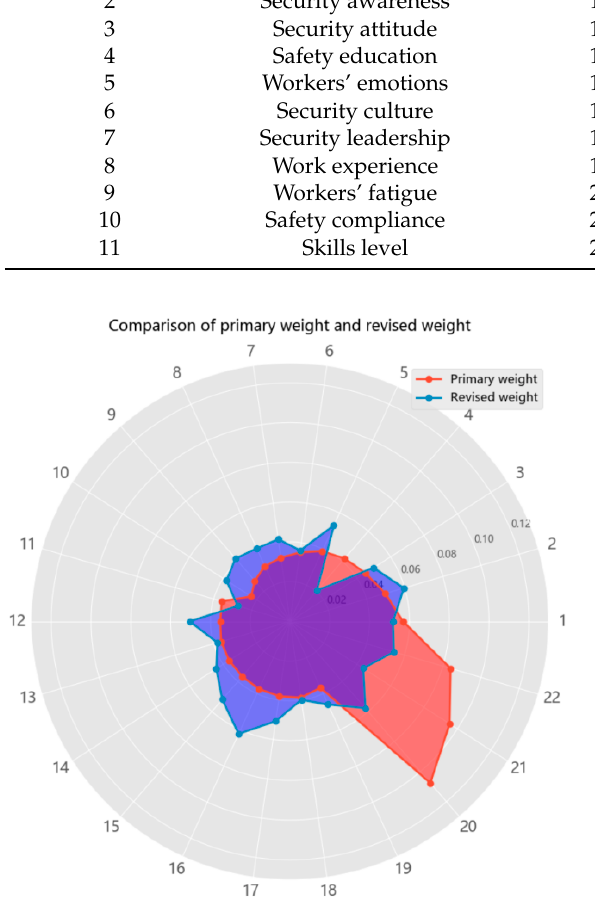
Figure 5. The comparison of the primary weight and the revised weight.